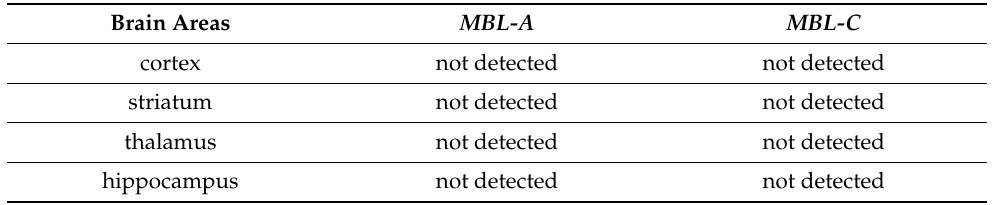
Figure 9. ( A – L ). The mRNA expression changes of collectin 11, ficolin A, and ficolin B in the cortex, striatum, thalamus, and hippocampus of TBI compared to sham-injured animals at different time points (24 h–5 weeks). The data are given as fold changes relative to the control as mean ± SEM (sham groups, n = 3–8; TBI groups, n = 4–8). * p < 0.05; *** p < 0.001 show differences considered statistically significant between the sham and TBI groups, + p < 0.05; ++ p < 0.01; +++ p < 0.001 show differences considered statistically significant comparing to the 24 h TBI group; # p < 0.05; ## p < 0.01; ### p < 0.001 show differences considered statistically significant comparing to the 4th day TBI group; & p < 0.05; && p < 0.01; show differences considered statistically significant when comparing to the 7th day TBI group; ˆ p < 0.05; ˆˆˆ p < 0.001 show differences considered statistically significant comparing to the 2 weeks TBI group as estimated by two-way ANOVA followed by Bonferroni’s post hoc test. Table 1. The mannose binding lectin A ( MBL-A ) and mannose binding lectin C ( MBL-C ) mRNA expression in brain structures (cortex, striatum, thalamus, and hippocampus) of sham/TBI-injured mice at selected time points (24 h, 4 days, 7 days, 2 weeks, 5 weeks) was not